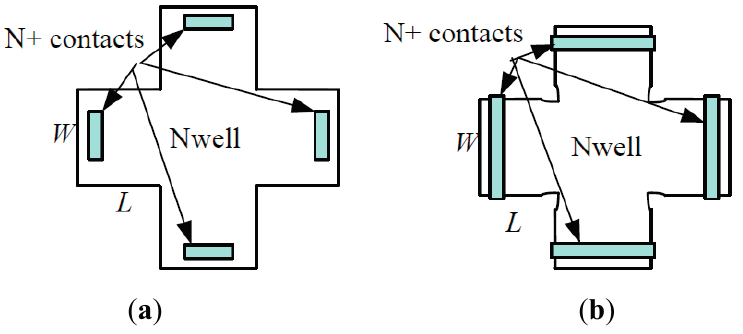
Figure 1. Cross-like Hall plate. ( a ) Conventional short contact structure; ( b ) Long contact